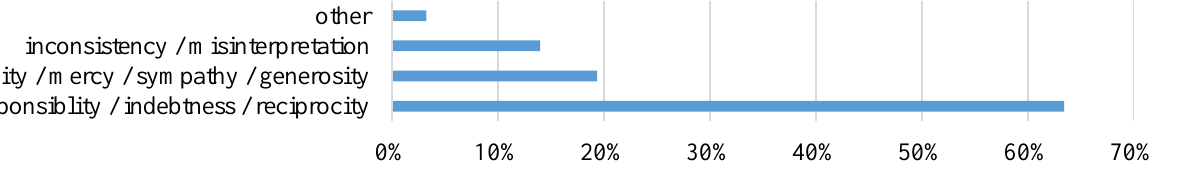
Figure 4. Survey results for Hypothesis 1 (endogenous games).